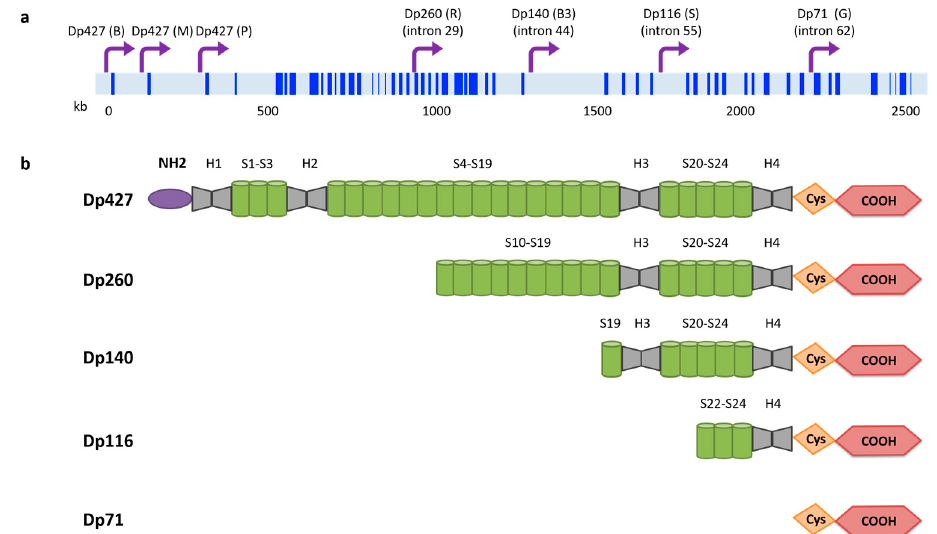
Figure 2. Schematic representation of the dystrophin gene and protein. ( a ) Linear representation of the DMD ( Duchenne muscular dystrophin ) gene. The location of the isoform-specific promoters (brain (B), muscle (M), Purkinje (P), retinal (R), brain-3 (B3), Schwann cell (S), and general (G)) is highlighted by violet arrows. Vertical blue bars indicate exons. ( b ) Structure of the different isoforms codified by the DMD gene. The full-length dystrophin represented consists of the following functional domains: